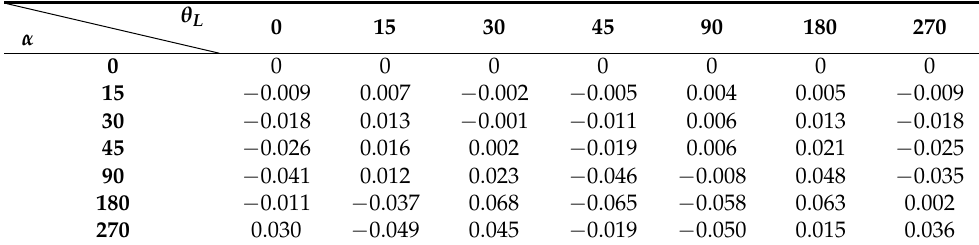
Table 3. Simulation data of the inclination error (unit: degree).